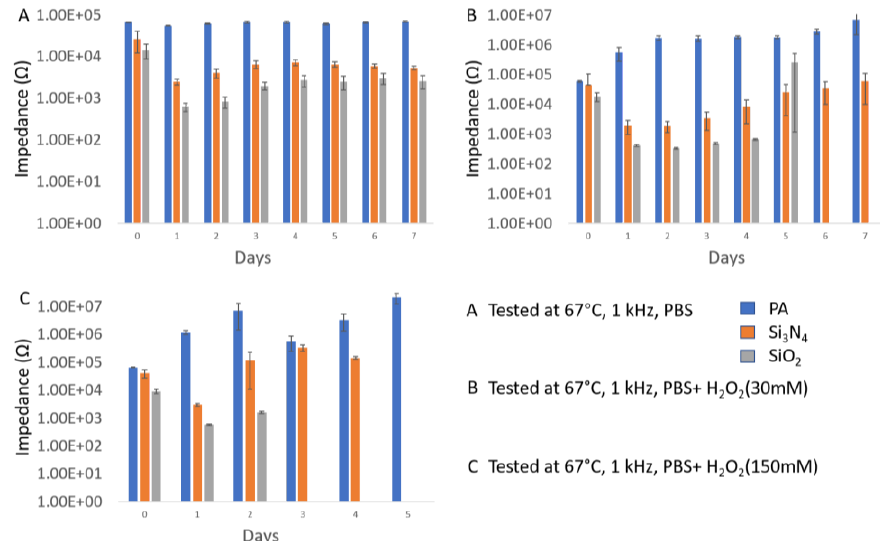
Figure 6. Impedance changes of open-tip tungsten wires coated with a single layer (1 µm) of PA, Si 3 N 4 , and SiO 2 , tested at 67 °C, 1 kHz, in three different solutions.